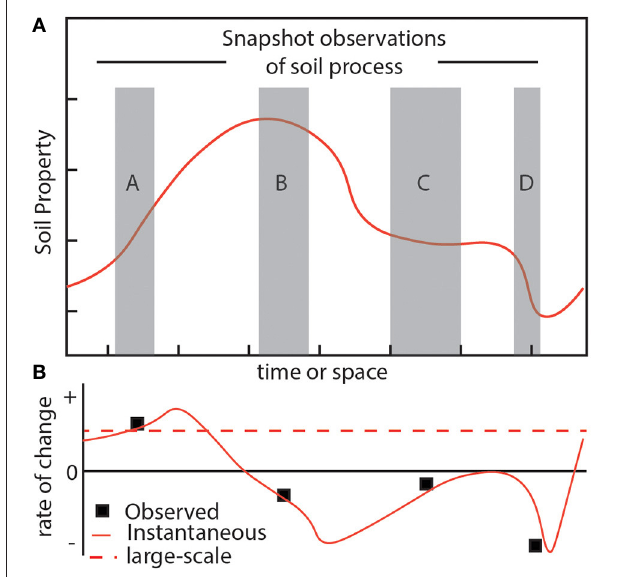
FIGURE 1 | The problem of scale-dependent soil variability emerges in part due to a violation of equilibrium assumptions. (A) Consider a hypothetical soil property, such as carbon content, which is not in equilibrium and whose dynamics are represented by a plot of the auto-correlation values across time or space (solid orange line). Actual observations of this property are limited to finite spatial or temporal scales (gray boxes), though serve as the basis for characterizing the system state and its relationship to this hypothetical property. (B) Using the snapshot observations (gray boxes) to calculate meaningful system parameters (small black boxes), such as carbon turnover, illustrates how it would be difficult, if not impossible, to retrieve the hypothetical large-scale evolution (red dashed line) of the property which is